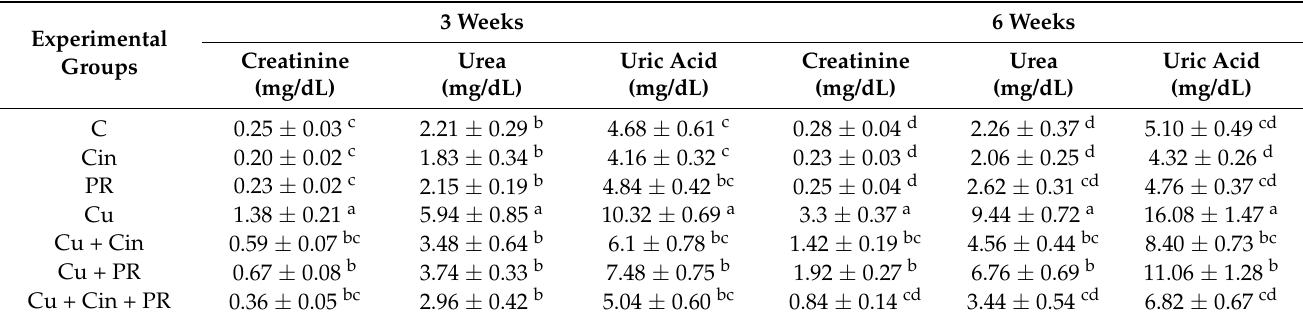
Table 3. Serum biochemical markers of renal functions in control and experimental groups at 3 and 6 weeks. Experimental Groups